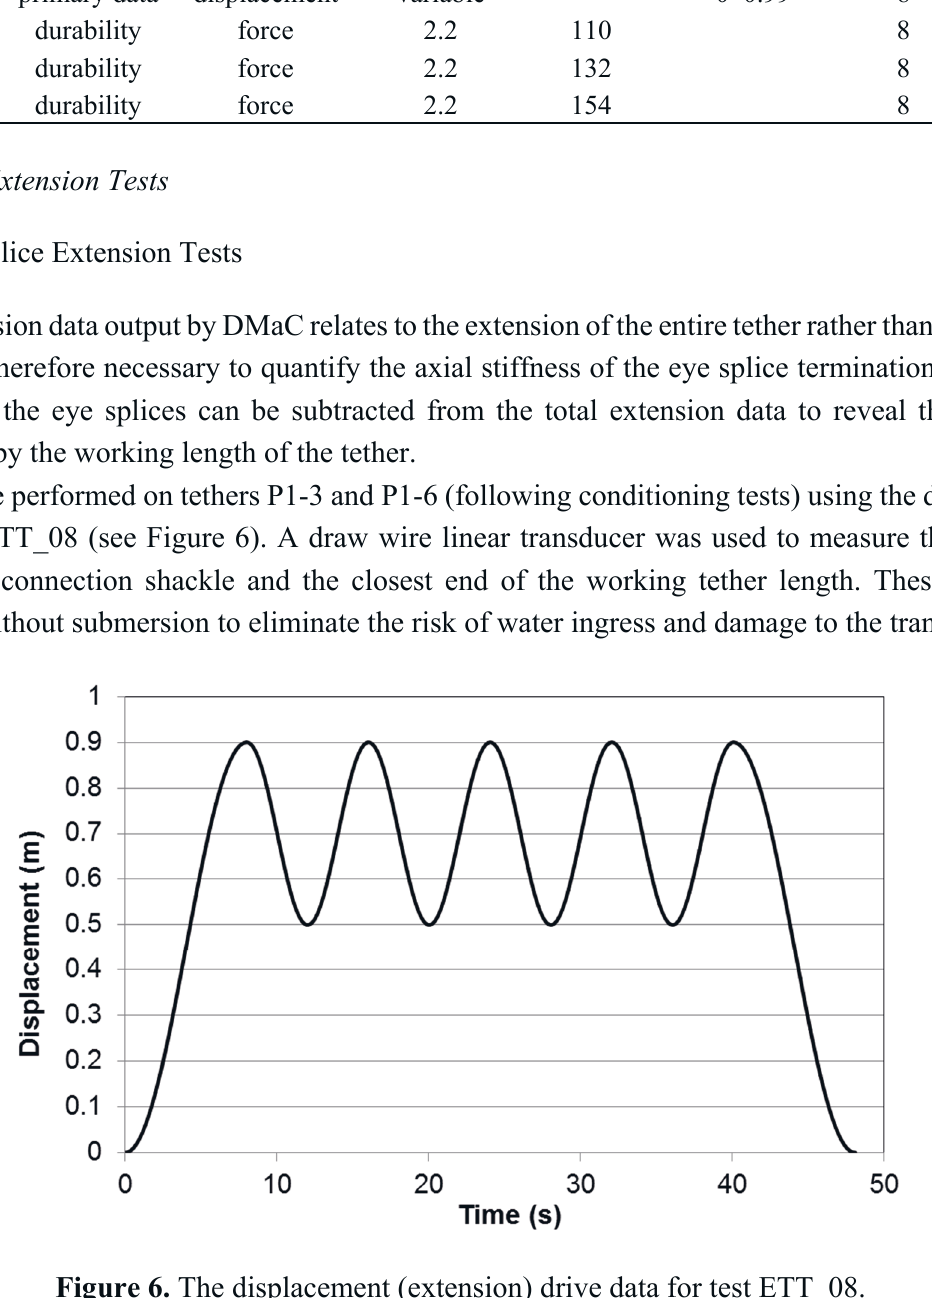
Figure 6. The displacement (extension) drive data for test